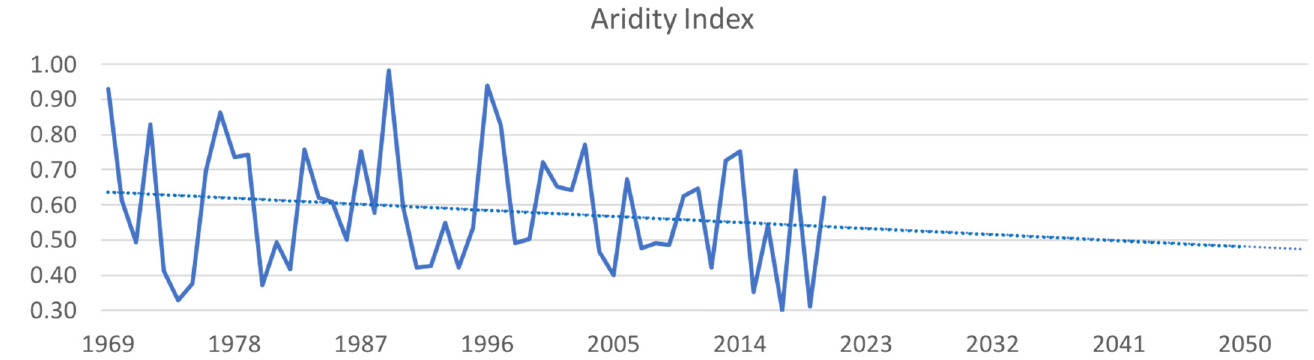
Figure 3. Aridity index in the study area and linear projection for the year 2050.